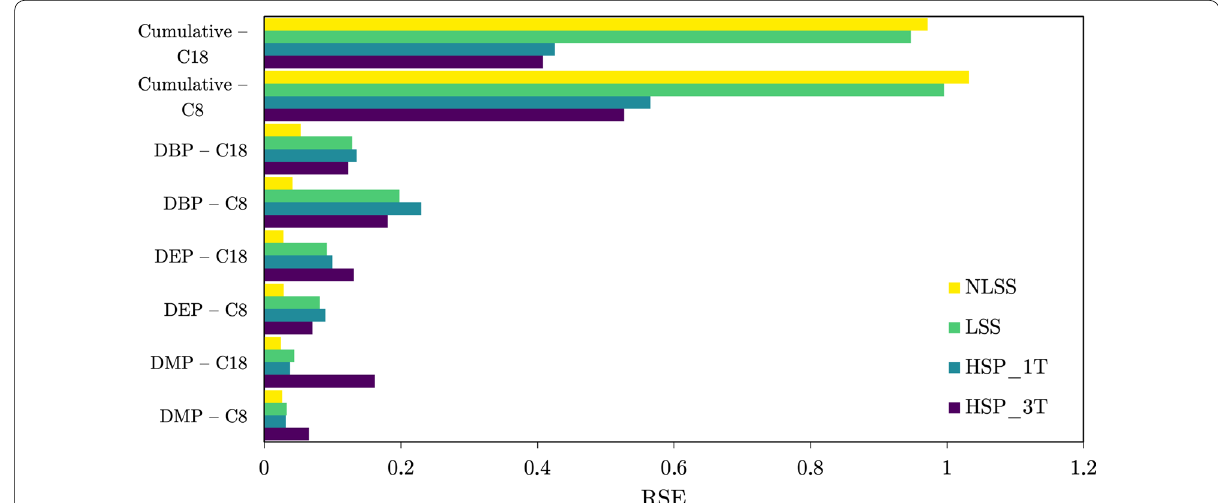
Fig. 3 A comparison of the RSE values for the investigated models. NLSS: nonlinear solvent strength model, LSS: linear solvent strength model, HSP_1T: HSP model with one temperature, HSP_3T: HSP model with three